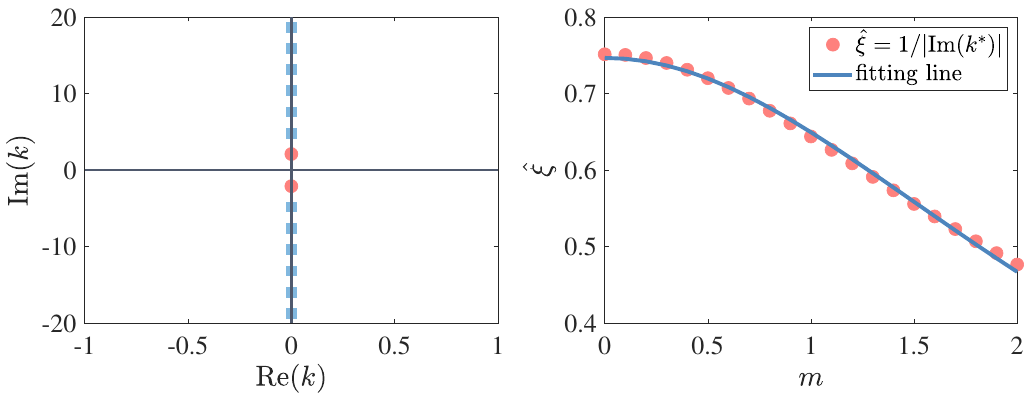
Figure 3 . (Left panel) QNMs in the complex k -plane for m = 2 and ω = 0 . The leading poles near- est the real axis, marked by red dots, determine the behavior of correlations at large distances. The blue squares are the sub-leading poles which are not important to the correlations. (Right panel) Coherence length ˆ ξ of the order parameter at the “freeze-out” time versus the graviton mass m . The red dots represent ˆ ξ = 1 / | Im( k ∗ ) | , where k ∗ are the leading QNMs, and the blue line is the fitting line ˆ ξ ≈ 0 . 7466 / (1 + 0 . 1496 m 2 ) from eq. (4.6). For both panels, we fix the quench rate as τ Q = 20